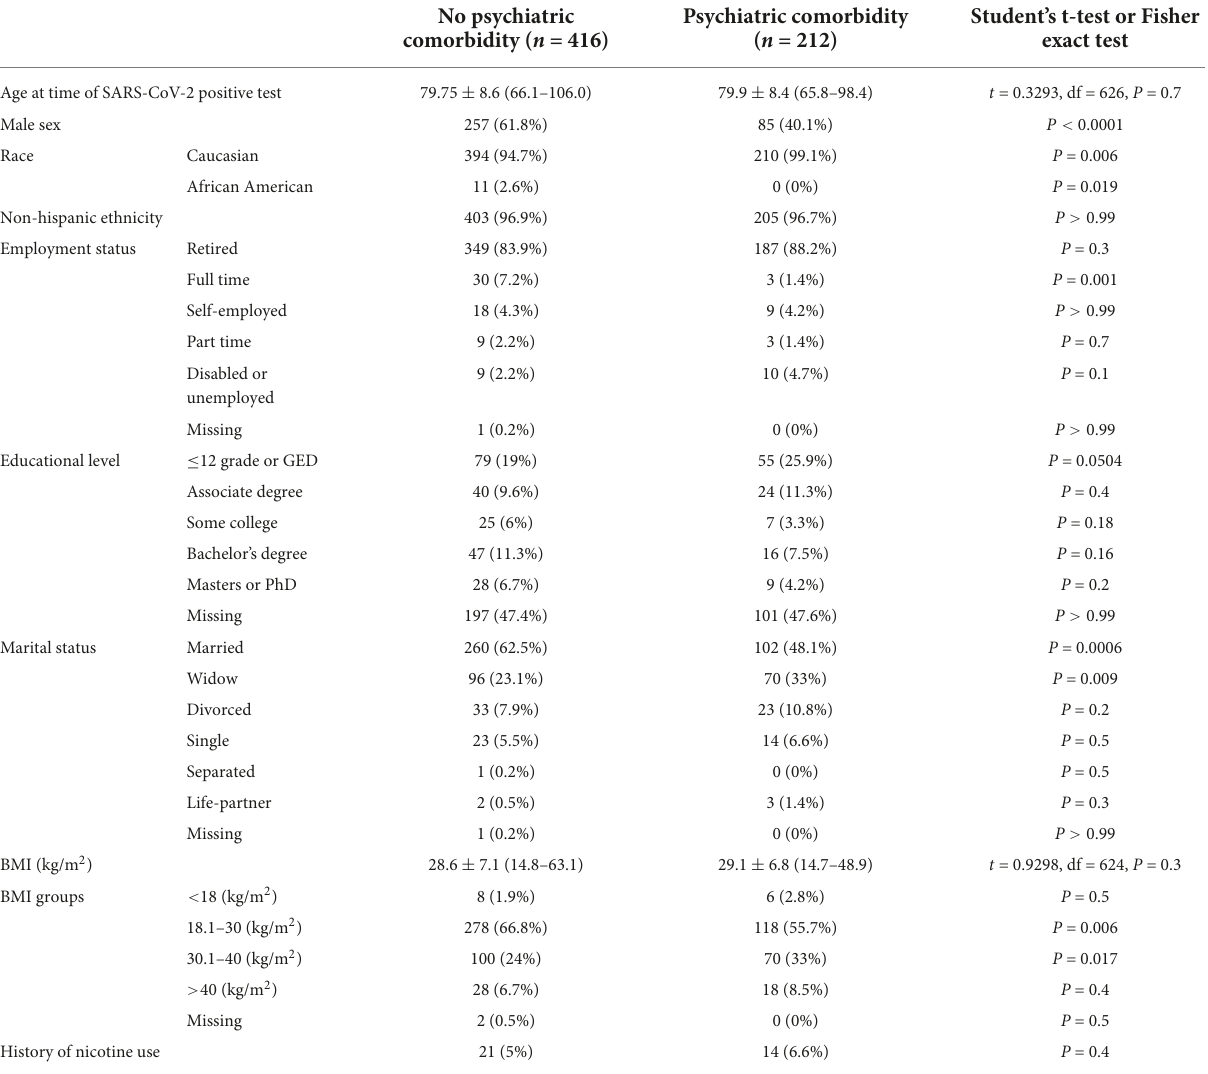
TABLE 1 Demographics.